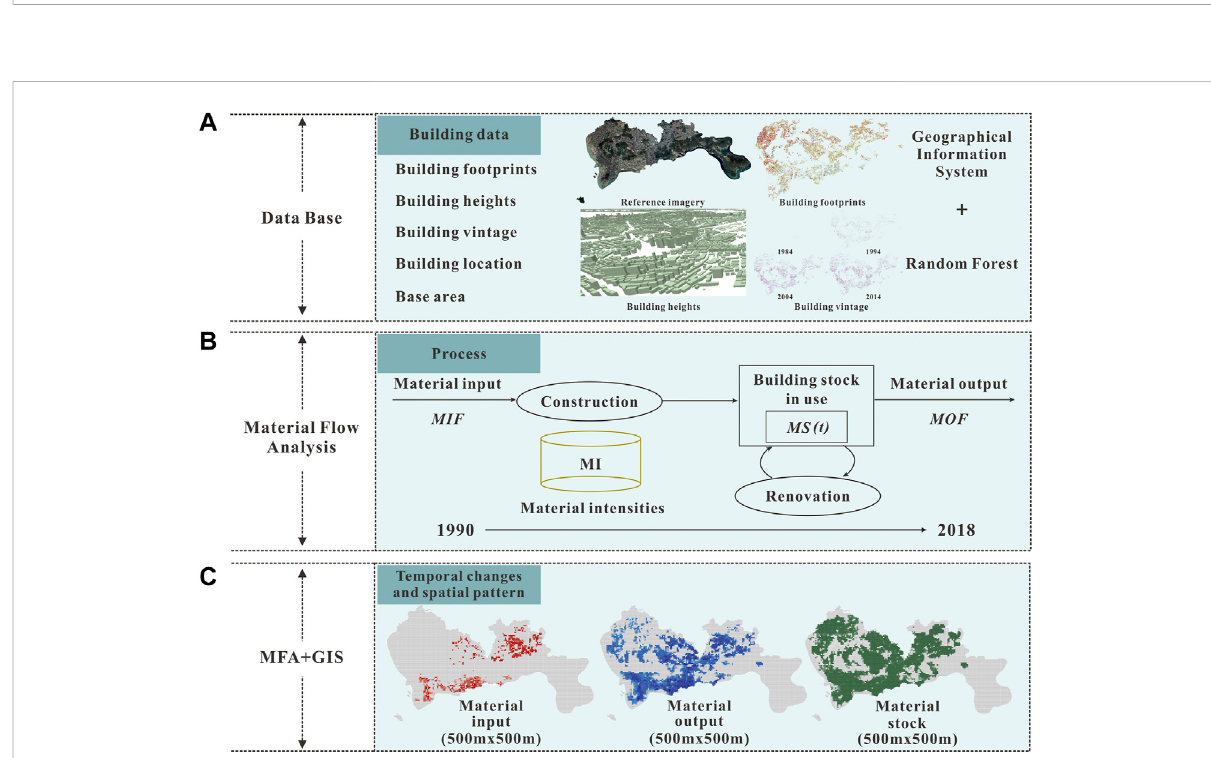
FIGURE 2 A framework for building data collection and estimation, material stock and fl ow quanti fi cation, and mapping in Shenzhen, China. Panel (A) shows the dataset of this study. Panel (B) shows the process of material fl ow analysis for the time changes. Panel (C) shows the combination of MFA and GIS for the spatial